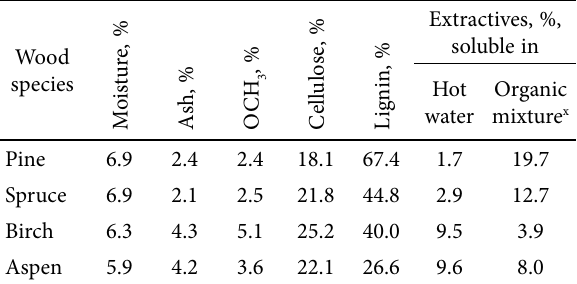
Table 1. Chemical composition of